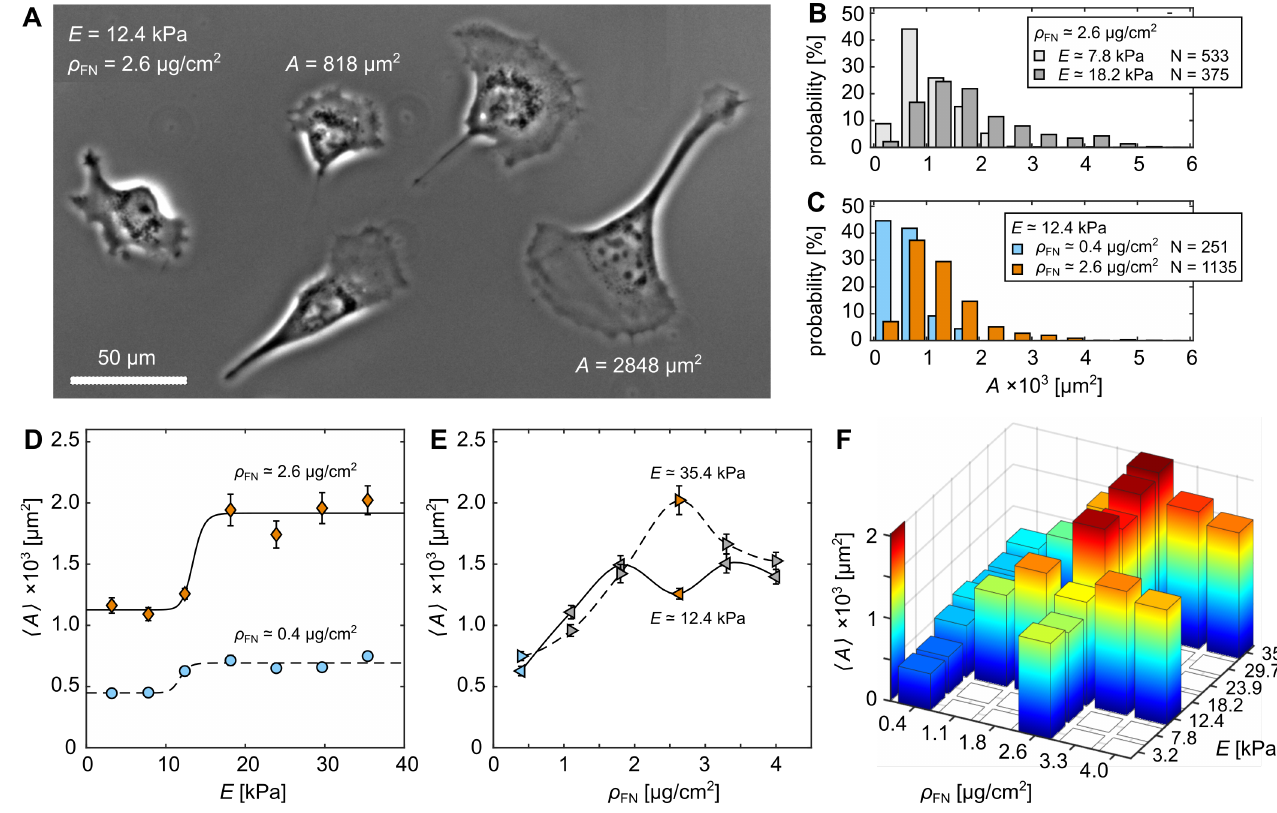
Figure 3. Cell area dependence on functionalized rigid hydrogels. ( A ) Phase contrast image of C2C12 cells on substrate rigidity E (cid:39) 12.4 kPa and fibronectin coating density ρ FN (cid:39) 2.6 µ g/cm 2 . ( B ) Probability histograms of projected cell areas A for two substrate rigidities E at constant fibronectin density ρ FN (cid:39) 2.6 µ g/cm 2 . ( C ) Probability histograms of A for two different ρ FN at constant E (cid:39) 12.4 kPa. ( D ) Mean projected cell areas (cid:104) A (cid:105) as a function of E for two different ρ FN . The solid and dashed lines are fits of the Hill equation (Equation (4)). ( E ) (cid:104) A (cid:105) as a function of ρ FN at E (cid:39) 12.4 kPa (left pointed triangles) and E (cid:39) 35.4 kPa (right pointed triangles). The solid and dashed lines are visual guidance. ( D , E ) Another visualization of the distributions is illustrated in Figure S2. The color scheme used in ( C – E ) relates to cells that are cultured on substrates functionalized with ρ FN (cid:39) 0.4 µ g/cm 2 (blue) and ρ FN (cid:39) 2.6 µ g/cm 2 (orange). ( F ) Two-dimensional histogram of (cid:104) A (cid:105) as a function of E and ρ FN . The error-bars indicate standard error (see Section